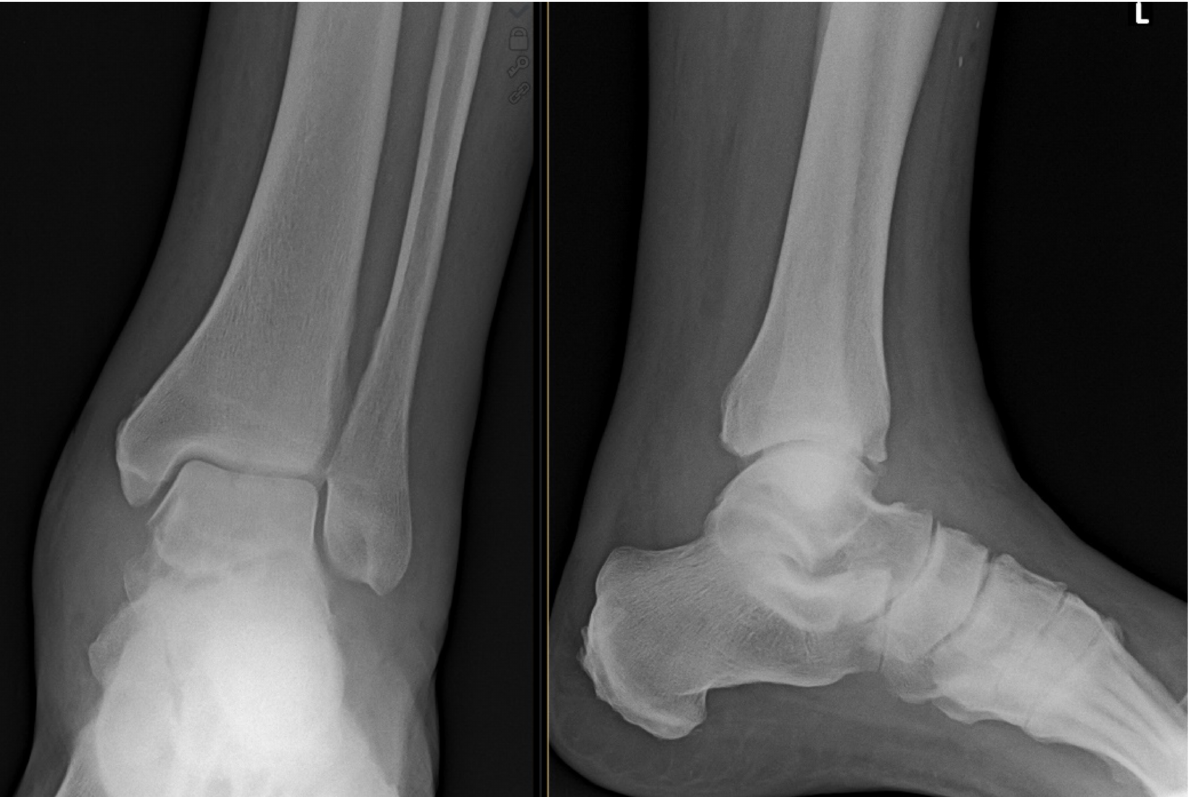
Figure 1. Initial X-ray image of the left ankle. The image shows normal picture with no detectable osteolytic